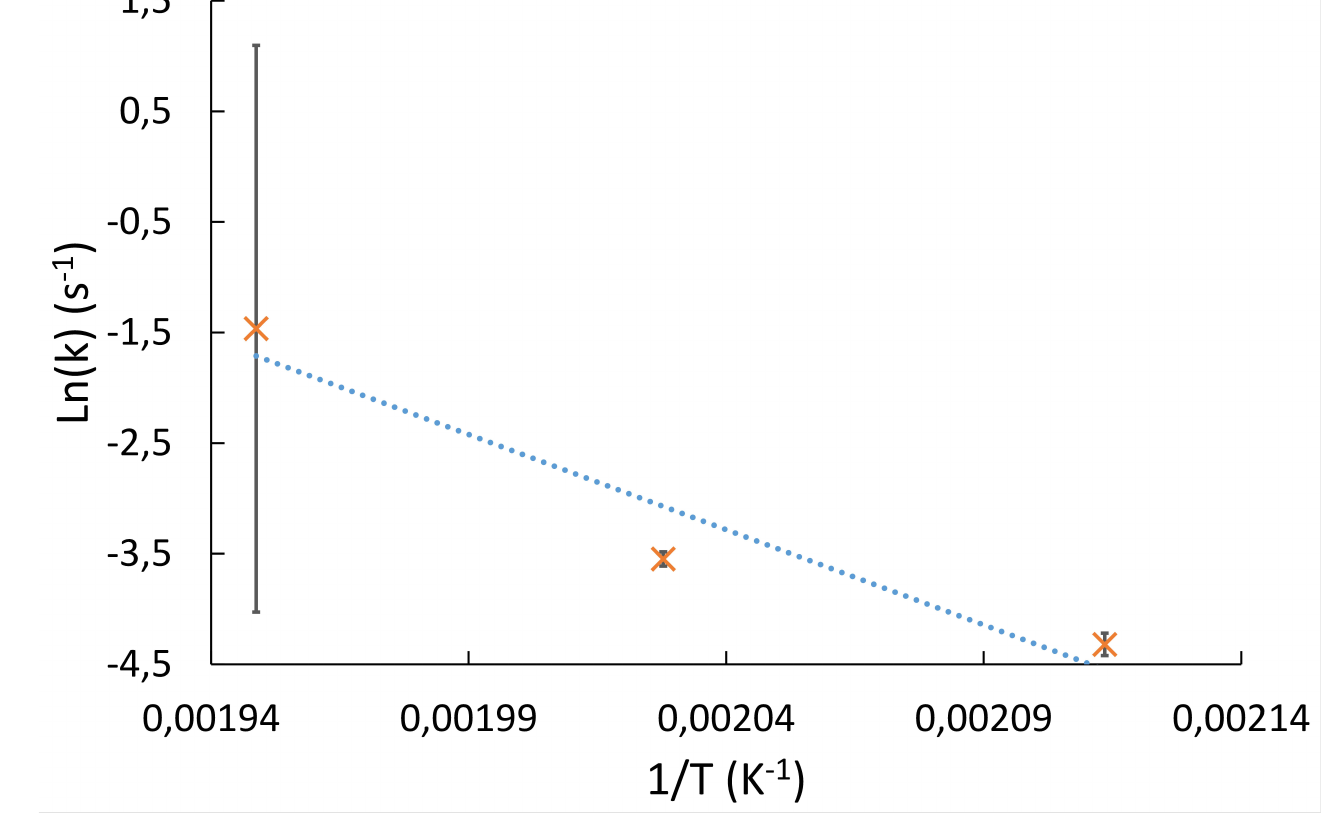
Figure 3. Exponential fitting of k constants of Model 3 between 200 and 240 ◦ C before adjustment.